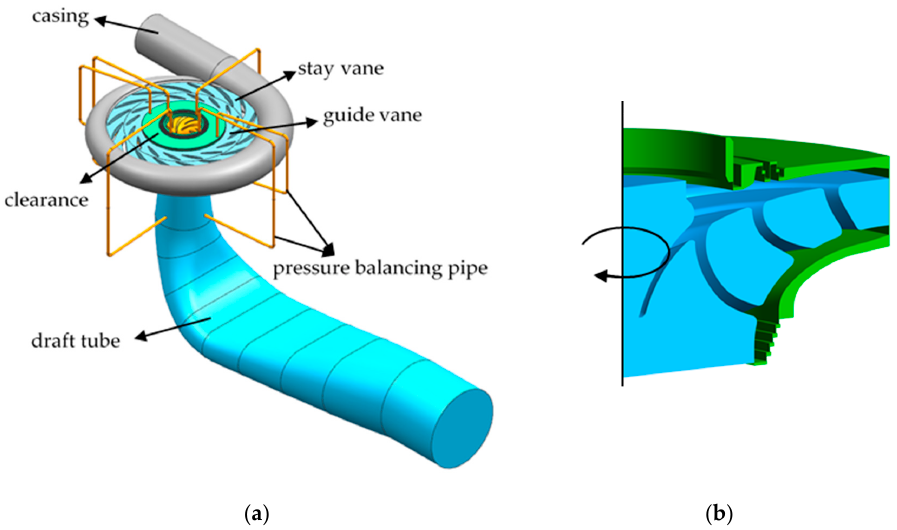
Figure 5. The pump ‐ turbine unit ( a ) pump ‐ turbine unit; ( b ) runner (blue) and clearances (green). The flow domain was discretized by tetrahedral mesh and hexahedral mesh. The to